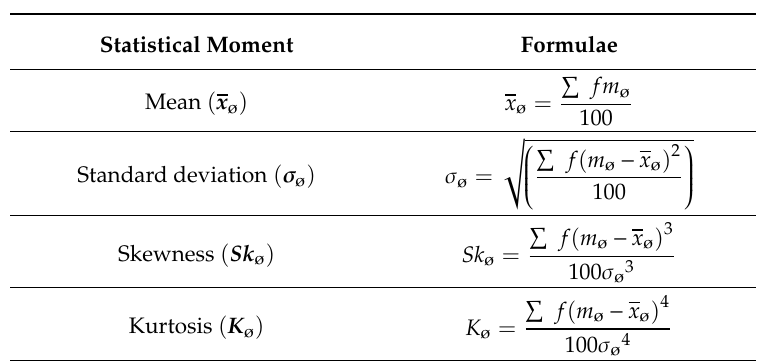
Table 1. Statistical formulae of the logarithmic method of moments [14]. x ø = mean; σ ø = standard deviation; Sk ø = skewness, K ø = kurtosis; f = the frequency in percent; and m ø = the mid-point of each class interval in phi ( ø ) units.